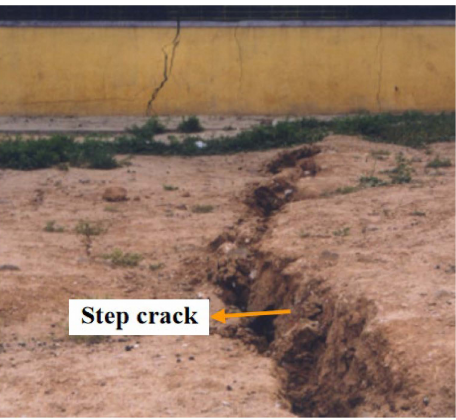
Figure 3. Surface step cracks in 6206 working face of Wangzhuang Coal Mine.